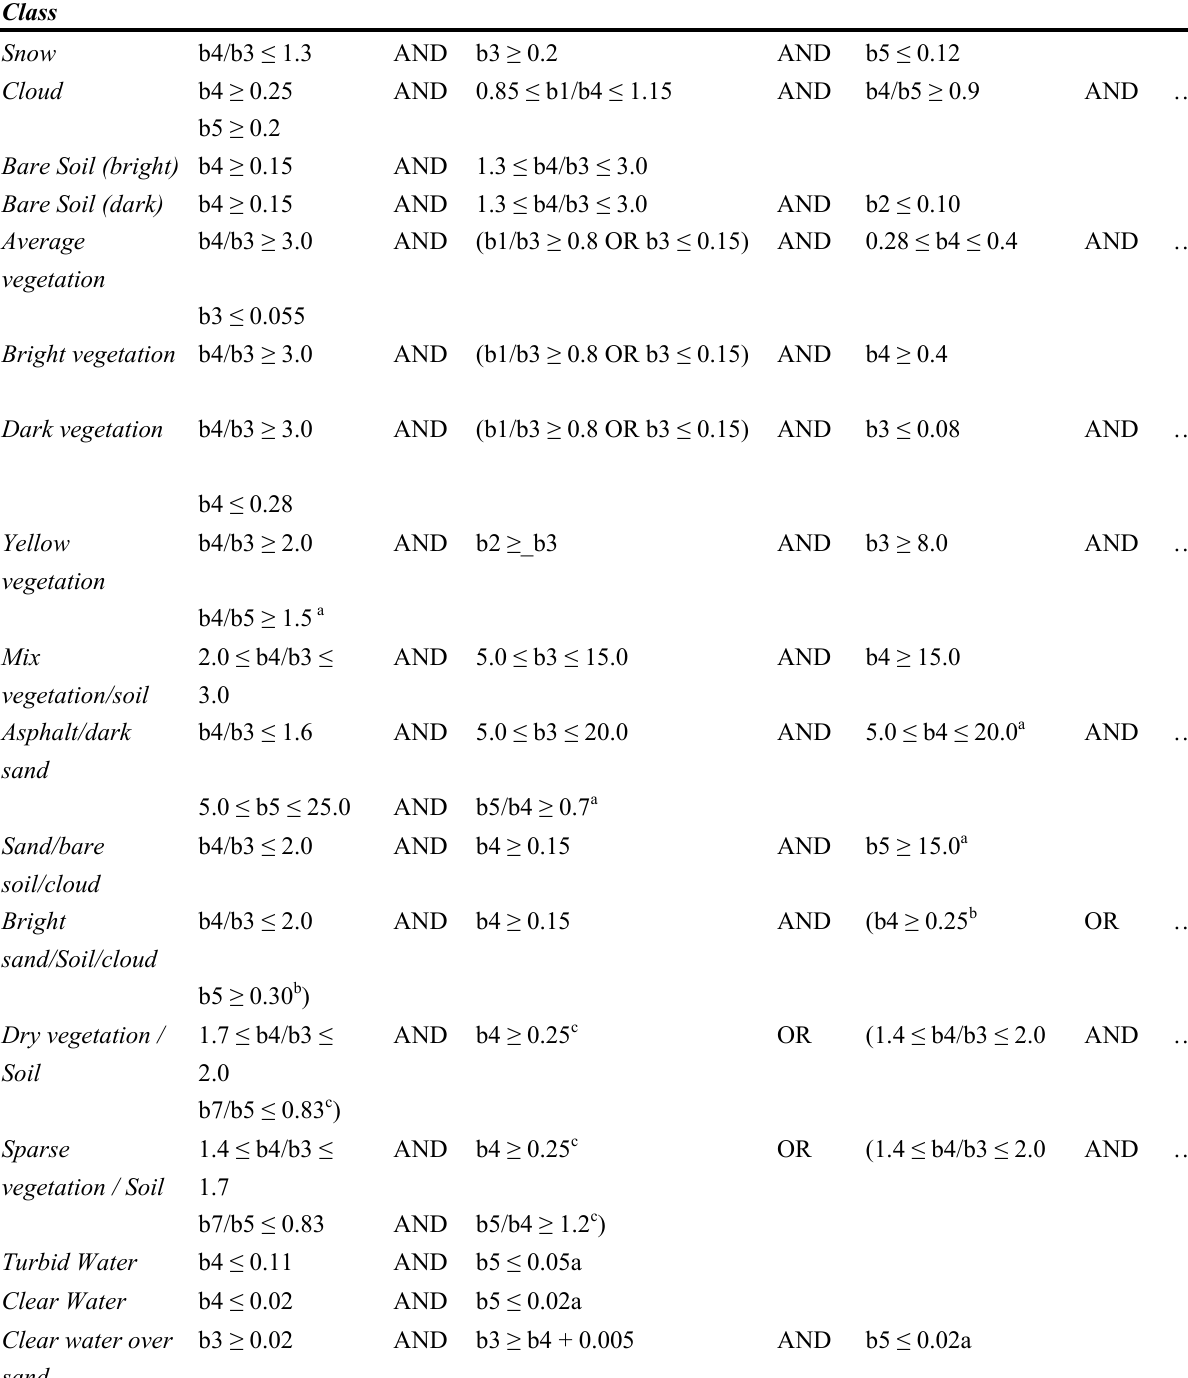
Table 1 . Decision rules used in SPECL classification, based on reflectance measured at Landsat TM central wave bands: b1 is located at 0.48 μ m, b2 at 0.56 μ m, b3 at 0.66 μ m,